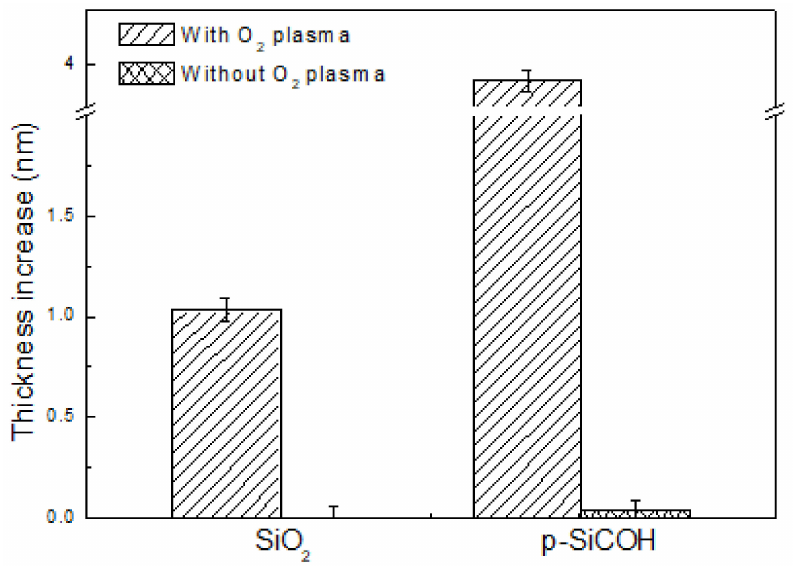
Figure 1. Thickness changes of SiO 2 and p-SiOCH films after O 2 plasma and DTMOS vapor